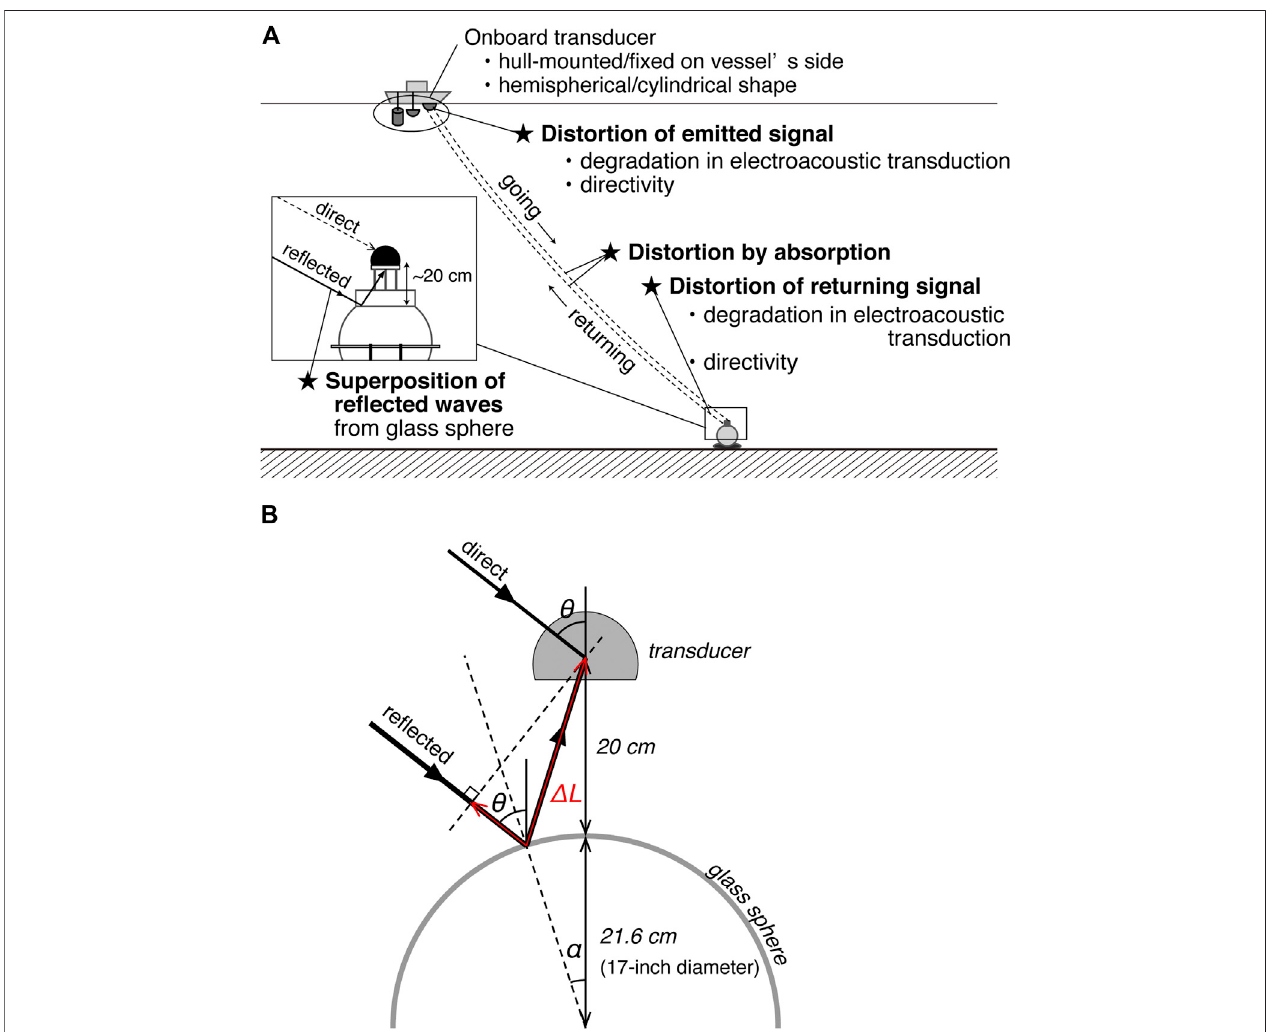
FIGURE9| Schematicdrawingofacousticranging. (A) Possiblecausesforthedistortionofacousticsignals. (B) Thepathofre fl ectedwavesfromtheglasssphere surface. The path length difference Δ L can be calculated for the incident angle θ of the incoming waves.